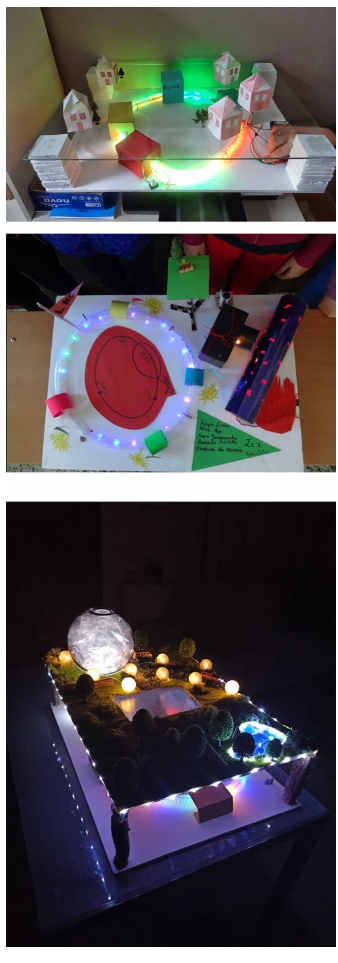
Fig. 1. LHC models made by K-6